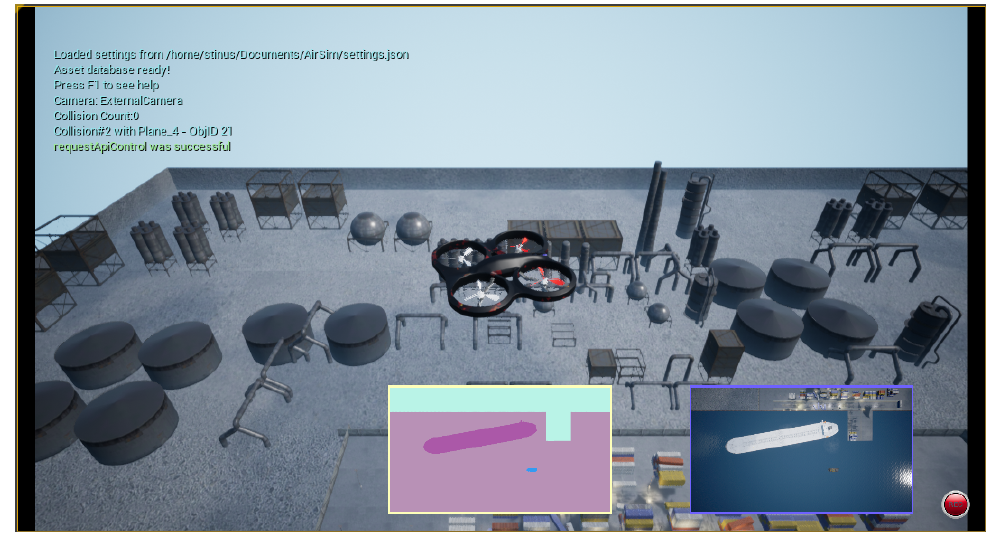
Figure 3. Interface of Airsim in unreal engine.